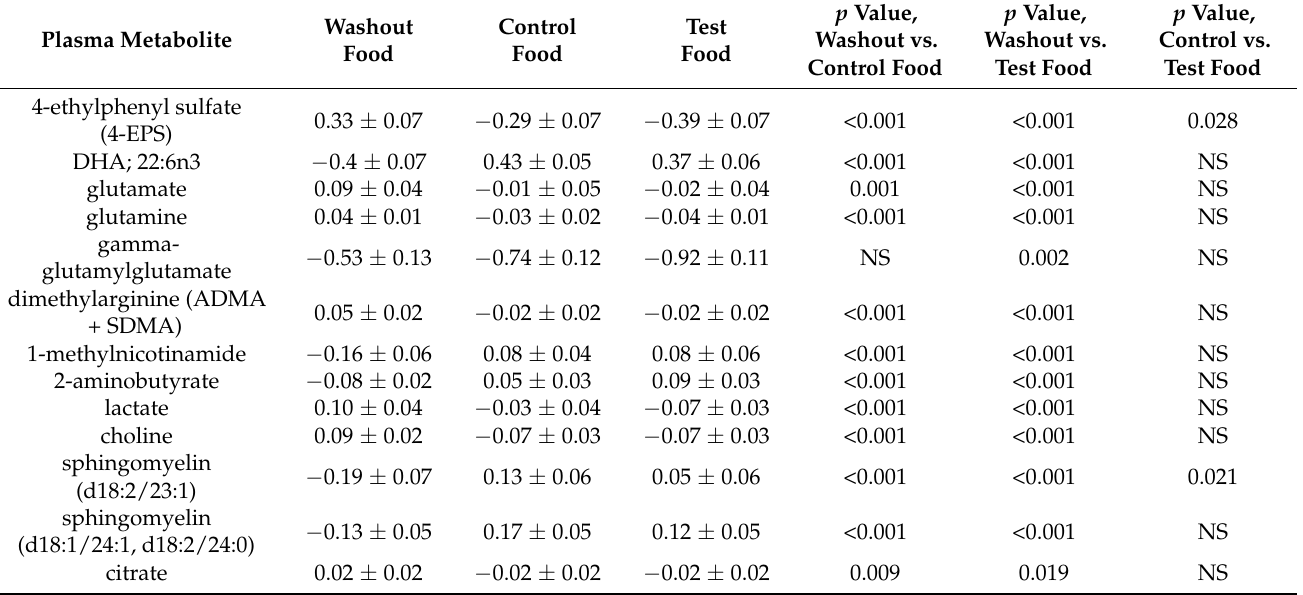
Table 5. Fecal metabolites of interest.